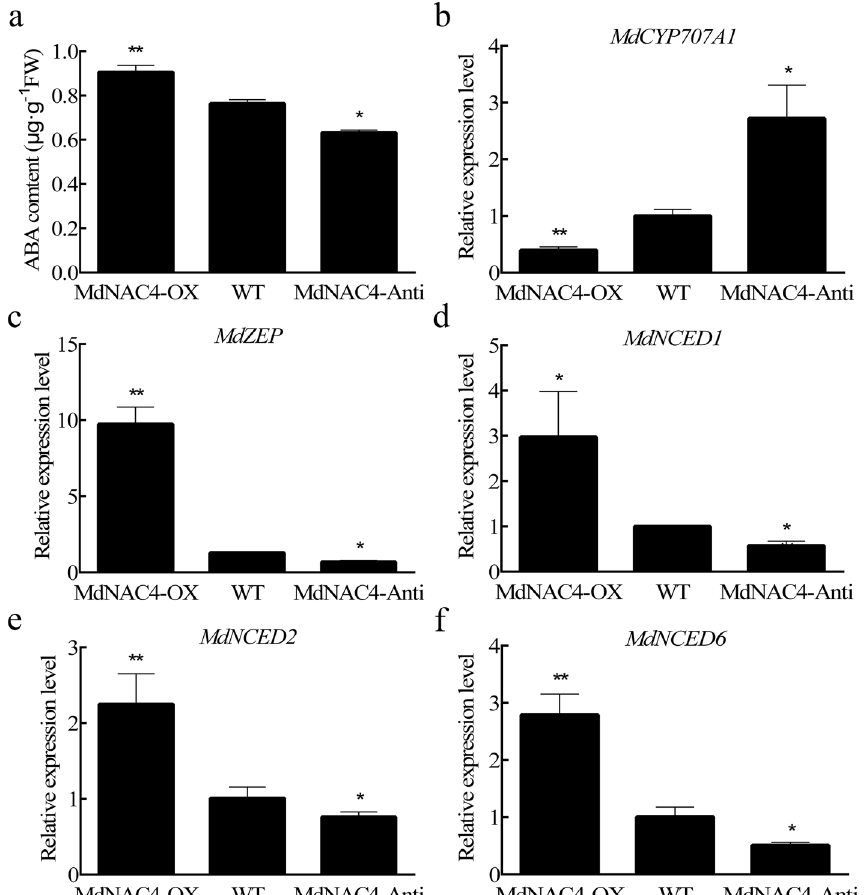
Fig. 2 ABA content and expression levels of ABA metabolism-related genes in 2-week-old apple calli. a ABA content. b‑f Expression levels of ABA metabolism-related genes. WT: wild-type; MdNAC4-OX: with MdNAC4 overexpression vector; MdNAC4-Anti: with MdNAC4 antisense vector. The WT expression level was set at 1. Error bars indicate the SDs of the three technical replicates and three biological replicates. Asterisks indicate significant differences between two independent samples according to t tests (*, P < 0.05 and **, P <